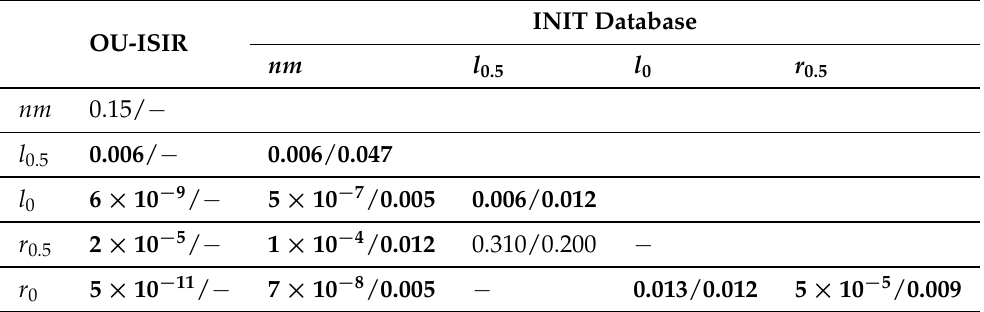
Table 1. Results of non-parametric tests between the column and the row groups in terms of Mann– Whitney p -value/Wilcoxon p -value. Bold p -values denote H 0 rejection at α = 0.05 (differences are significant). Symbol ‘–’ denotes a meaningless